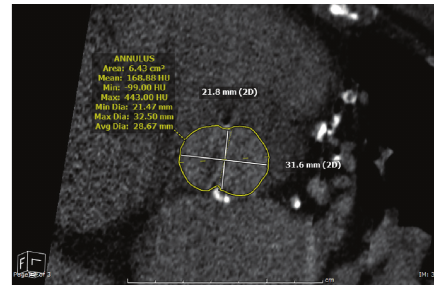
Figure1:CTdeterminedcross-sectionalaorticannulardimensions.